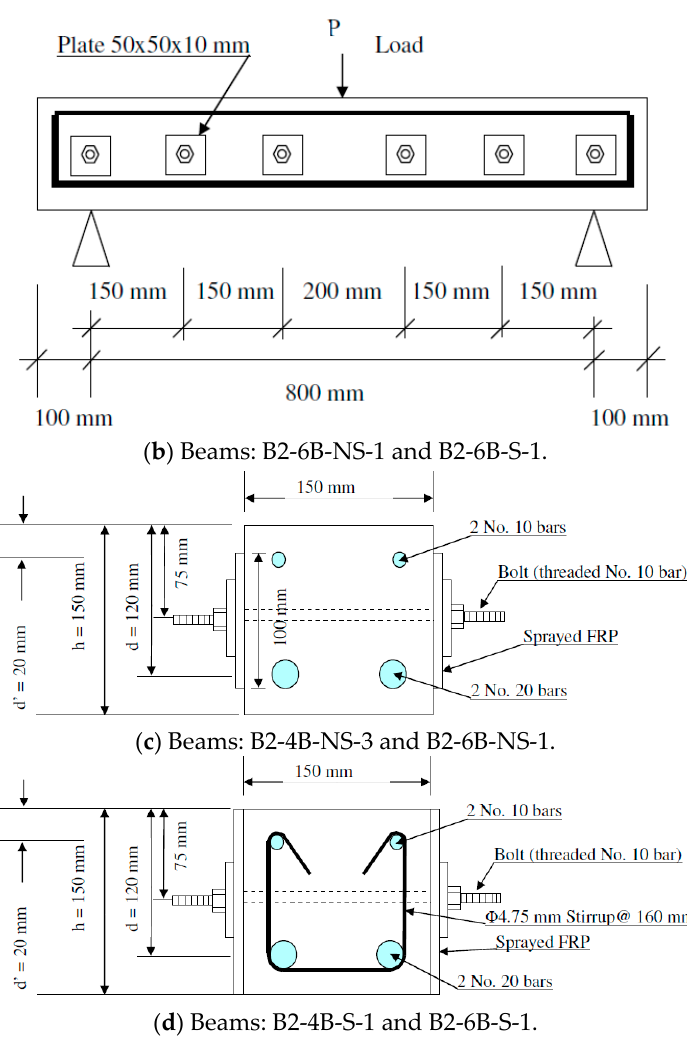
Figure 2. Bolt configuration of RC beams with sprayed GFRP: ( a ) four bolts; ( b ) six bolts; ( c ) cross-sections with no stirrups; ( d ) cross-sections with stirrups [22].